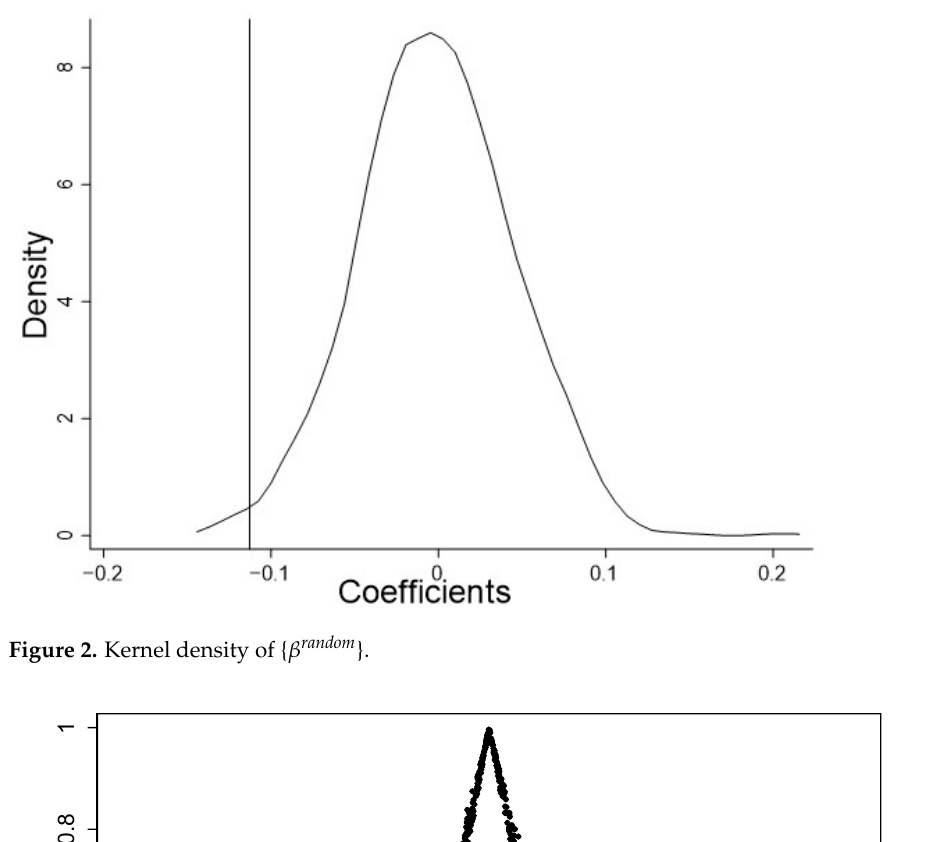
Figure 2. Kernel density of { β random }.